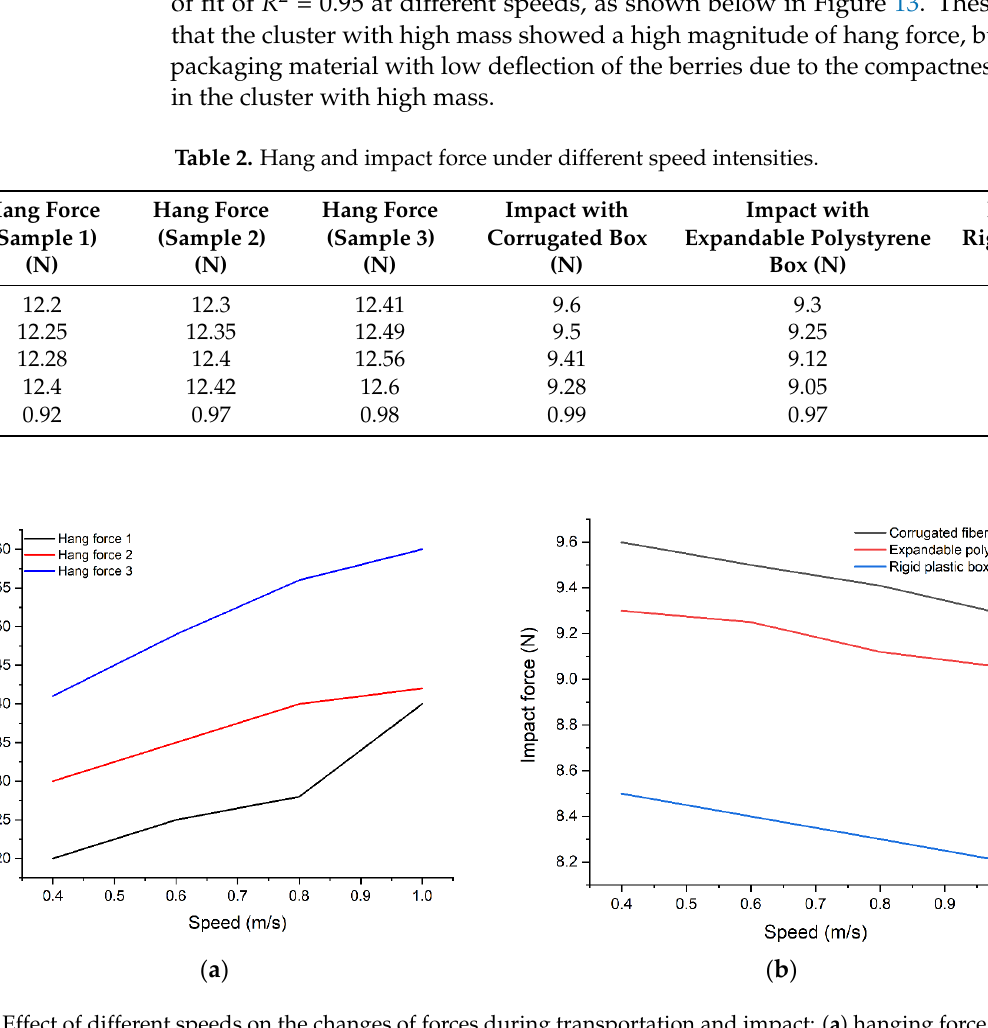
Figure 12. Effect of different speeds on the changes of forces during transportation and impact: ( a ) hanging force; ( b ) impact force.